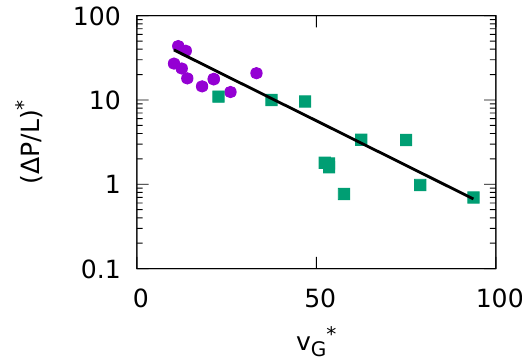
Figure 6. Characteristic curves diagram in dimensionless units ( ∆ P / L ) ∗ vs v ∗ in semilog scale. Symbols used follow the same G definition as in fig. 4. The solid line is a fit for the experimental